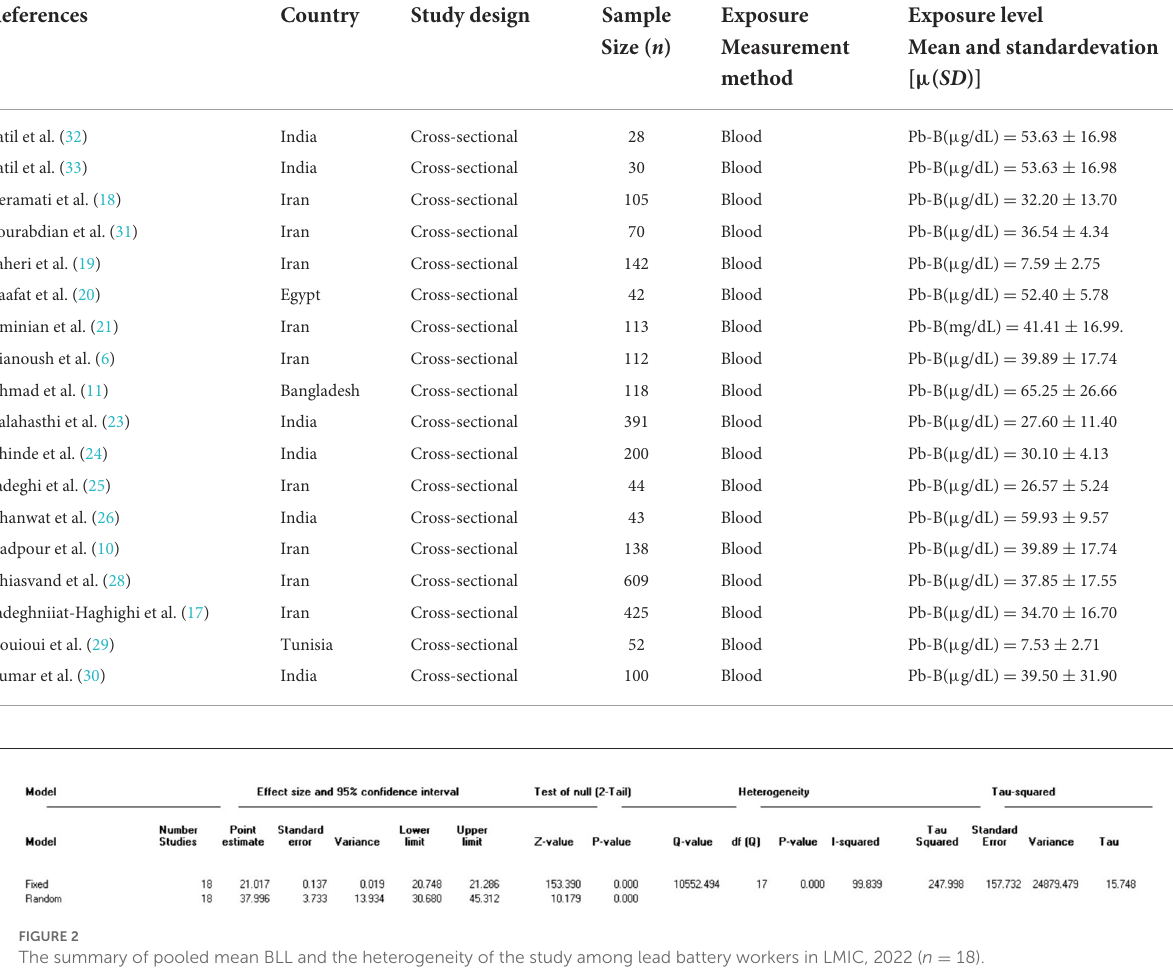
TABLE 1 Description of the study characteristics included in the systematic review and meta-anlysis of blood lead levels among battery factories in LMIC, 2022 ( n = 18).